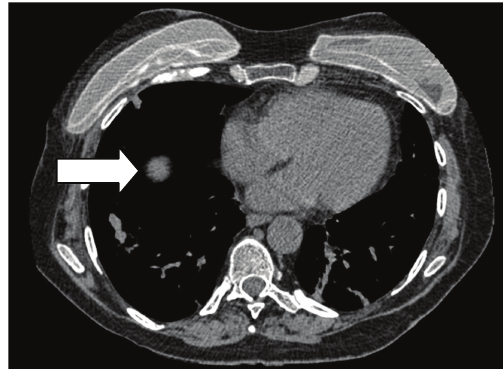
Figure 2: CT chest showing right lower lobe pulmonary nodule